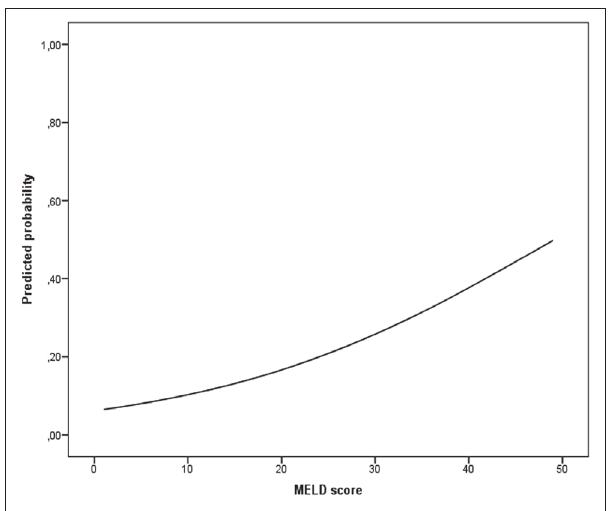
Figure 3) Kaplan-Meier patient survival curve for biochemical Model for End-stage Liver Disease (MELD) score categories ( ≥ 40 versus <40) at liver transplant (P=0.59)